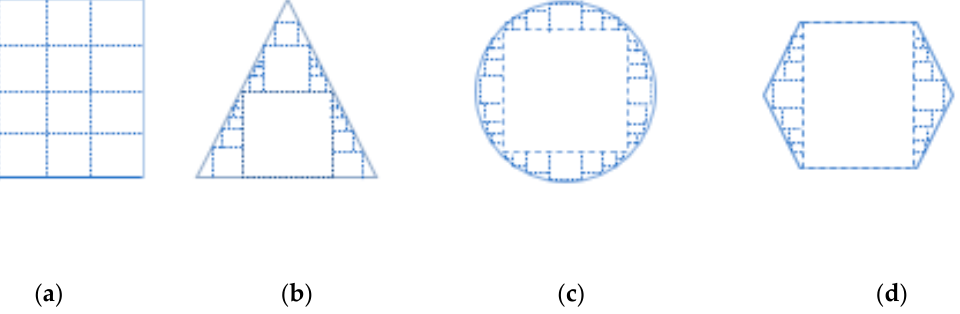
Figure 5. Activation fields of different shapes. ( a ) Normal activation field; ( b ) Oblique shape; ( c ) Arc shape; ( d ) Multi-oblique shape.